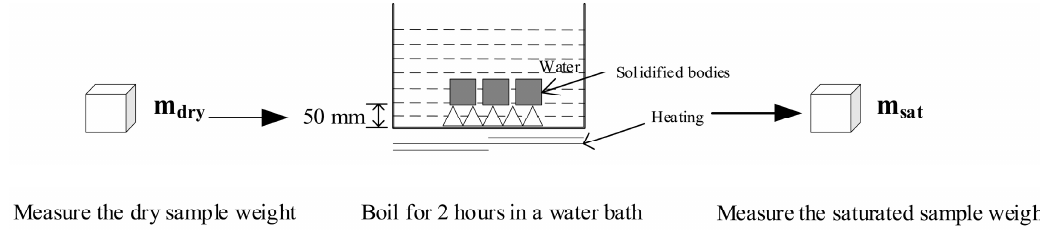
Figure 3. Schematic for measuring the porosity of CFBCFA and cement based solidified bodies.